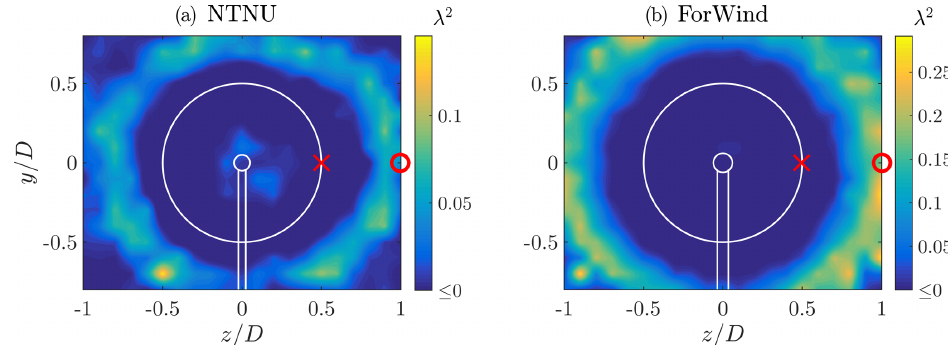
Figure 7. λ 2 for both turbines at γ = 0 ◦ . The timescales τ correspond to the length scale of the rotor diameter; cf. Eq. (8). The red markings × and ◦ show measurement positions for which p ( u τ ) were calculated as shown in Fig. 8. (a) NTNU turbine, (b) ForWind turbine. Note the different